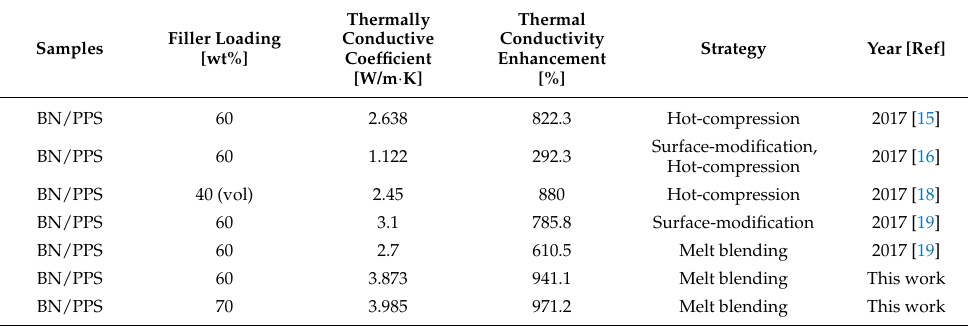
Table 4. Comparison of thermally conductive coefficient and thermal conductivity enhancement in BN/PPS composites.